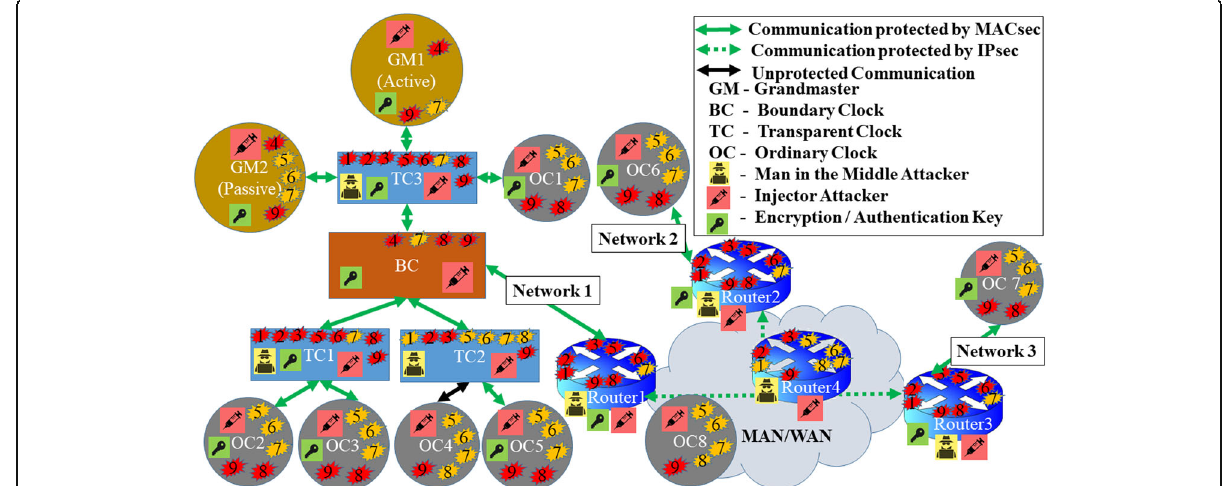
Fig. 2 Single-path PTP Network Model with Attacker Type as listed in Table